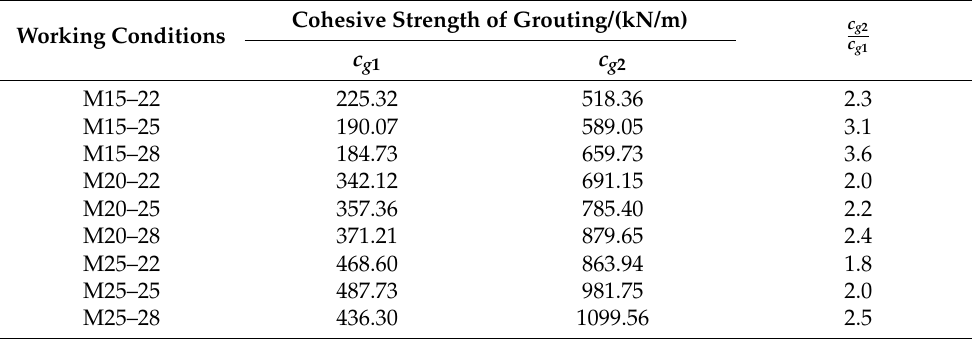
Table 5. Calculated values of grout cohesion under different conditions.